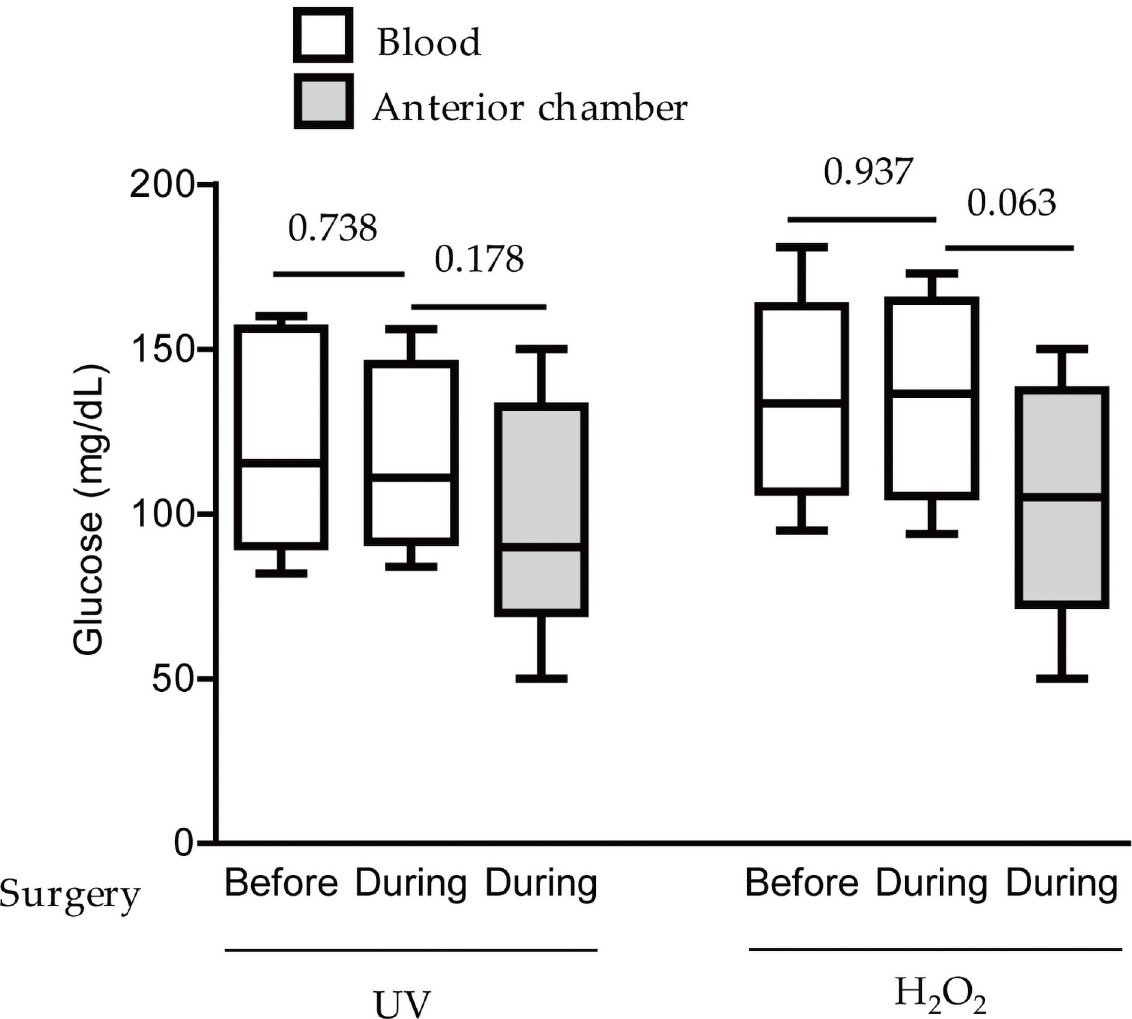
Fig 1. Glucose levels from the anterior chamber and blood in subjects with cataracts in Study 1. Quantitative analyses showed that there was no significant difference in glucose levels between the ‘before/during the surgery’, detected by UV-hexokinase (n = 10) and hydrogen peroxide (H 2 O 2 )-electrode (n = 8; unfortunately, 2 samples were lost during the surgery) methods. In addition, the levels from the anterior chamber and blood were not significantly different, p > 0.05. Graphs are presented as median with interquartile range, the 25th and 75th percentile. The data were analyzed using Student’s t -test and one-way ANOVA followed by a Bonferroni post hoc test. UV: UV-hexokinase method; H 2 O 2 : H 2 O 2 - electrode method.